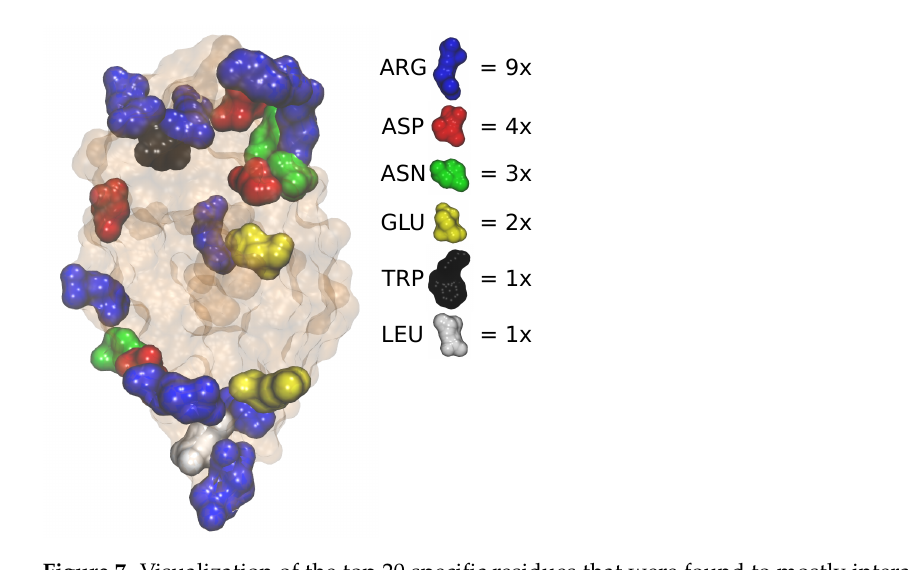
Figure 7. Visualization of the top 20 specific residues that were found to mostly interact with free arginine